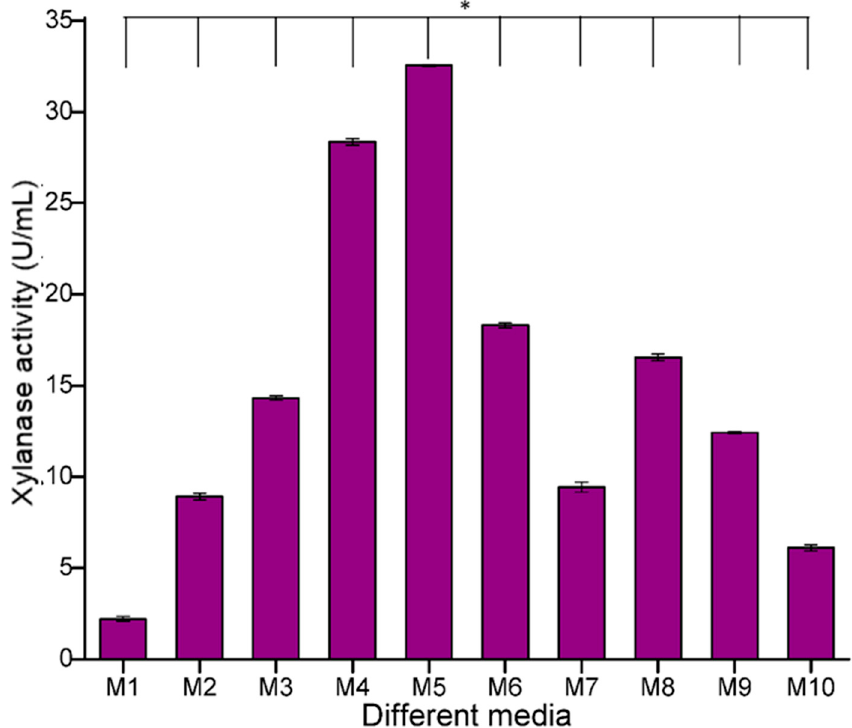
Figure 3. Screening of different media for xylanase production by B. safensis XPS7. All experiments were performed in triplicate. Bars display mean ± SD and statistical analysis was performed using one-way ANOVA with Tukey post hoc test, with p < 0.01 *.